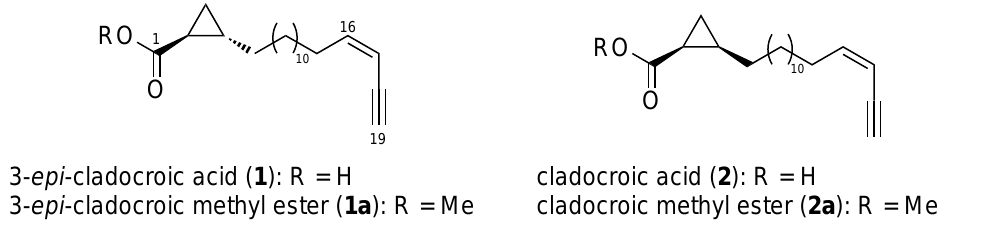
Figure 1. Structure of clodocroic acids 1 , 2 and their methyl esters 1a , 2a